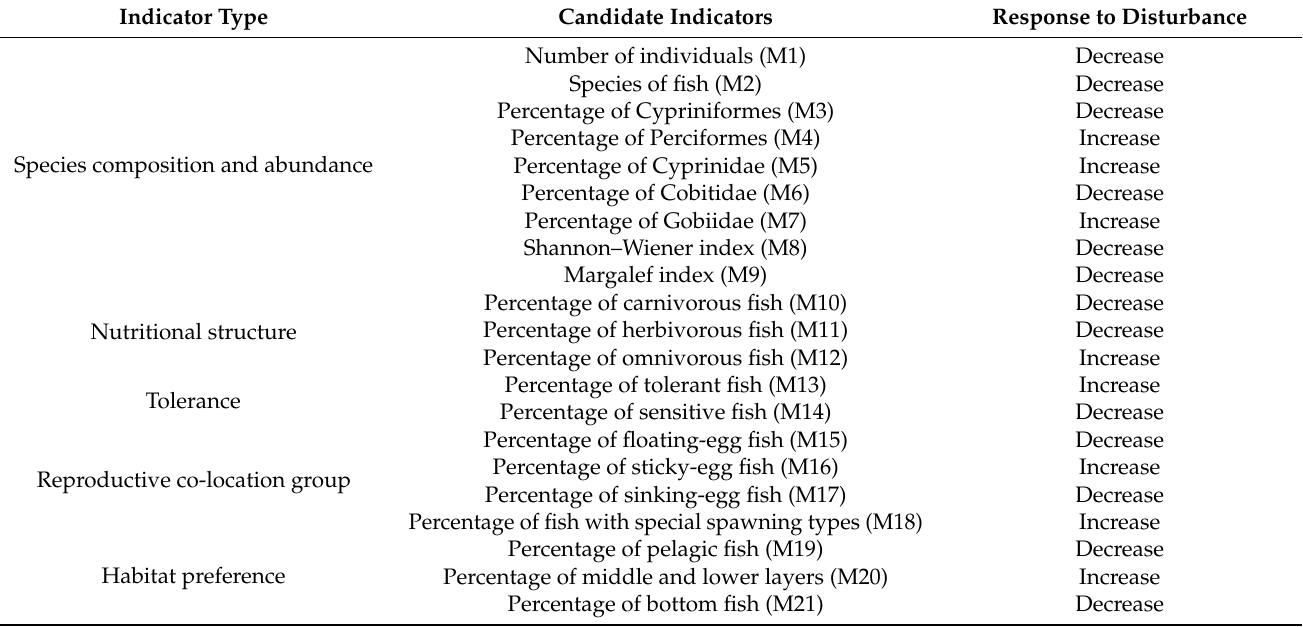
Table 1. Candidate indicators for the F-IBI and their expected directions of response to